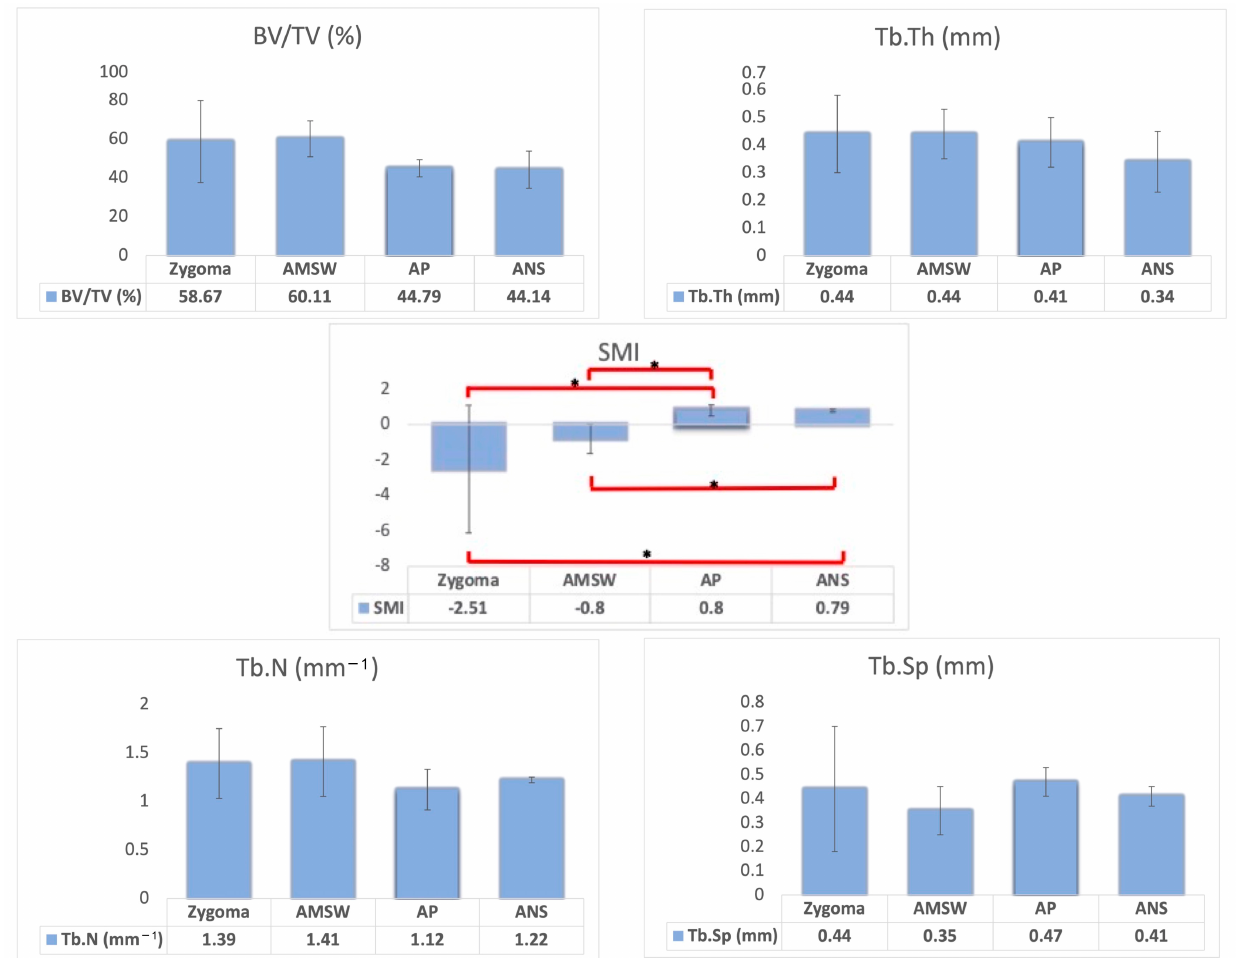
Figure 4. Comparison of parameters between bone grafts taken from different donor sites. * ANOVA; p < 0.05. Note: The sites of interest in this study are the zygomatic buttress (ZYGOMA), anterior maxillary sinus wall (AMSW), anterior palate (AP), and anterior nasal spine (ANS). Lastly, correlation analysis was done between different bone quality parameters